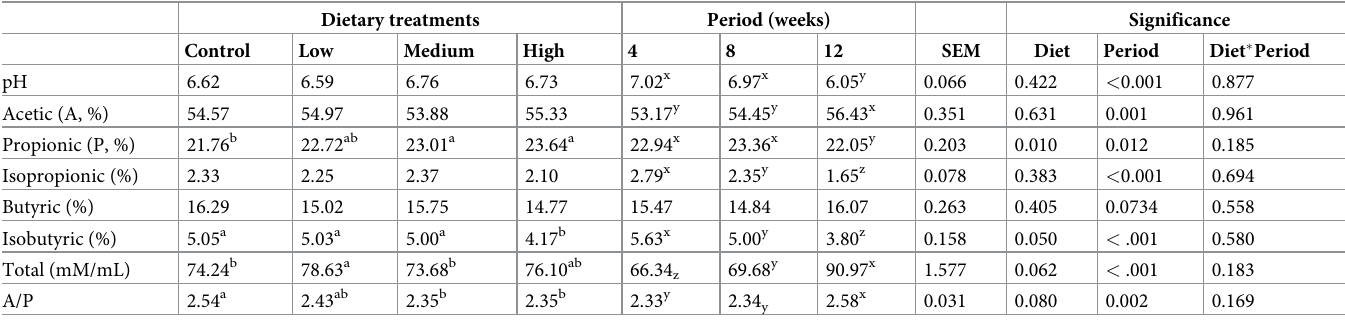
Table 8. Effects of increasing levels of lovastatin on rumen pH and VFA content. Dietary